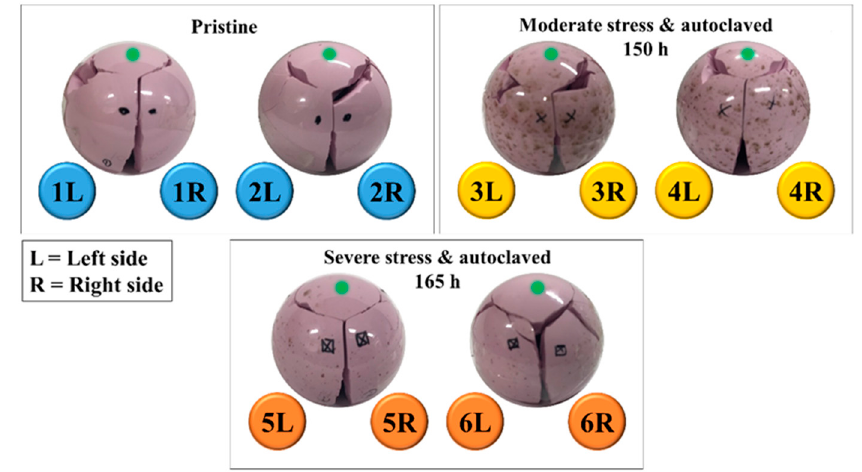
Figure 3. Reconstruction of two representative burst-strength-tested femoral heads tested against CoCr trunnions, for each of the respective testing conditions. The top of each femoral head has been marked with a dot.